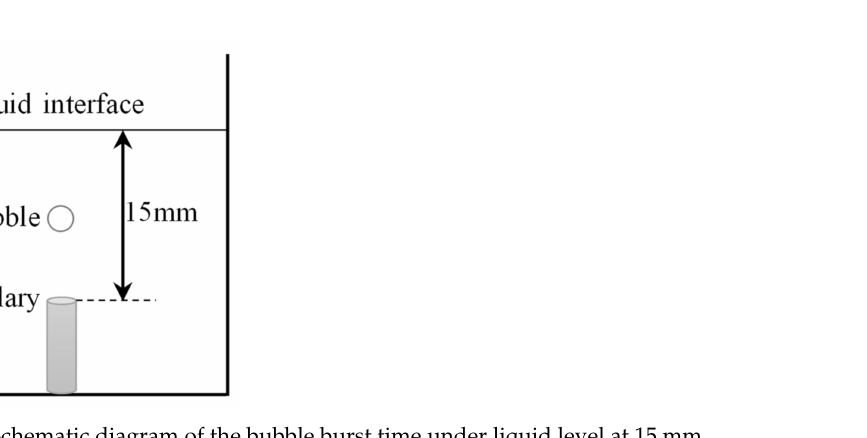
Figure 3. Schematic diagram of the bubble burst time under liquid level at 15